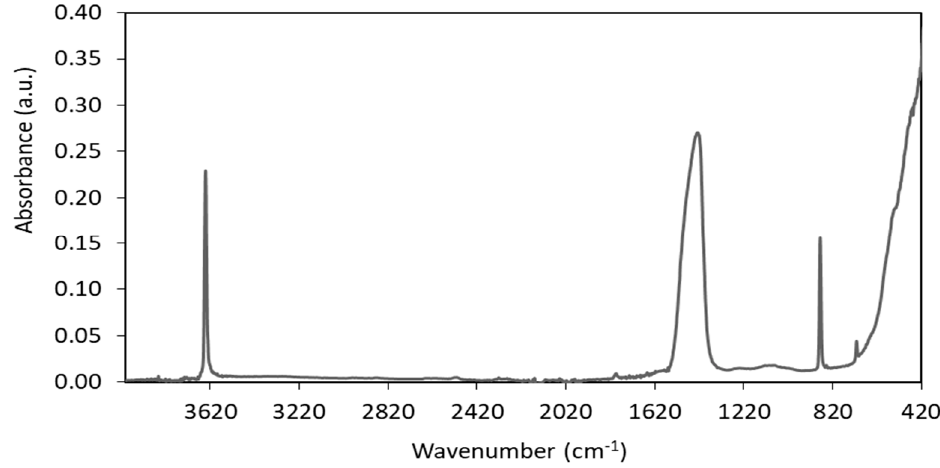
Figure 3. Fourier transformed infrared spectroscopy (FTIR) spectrum of unmodified nanosized CaO.